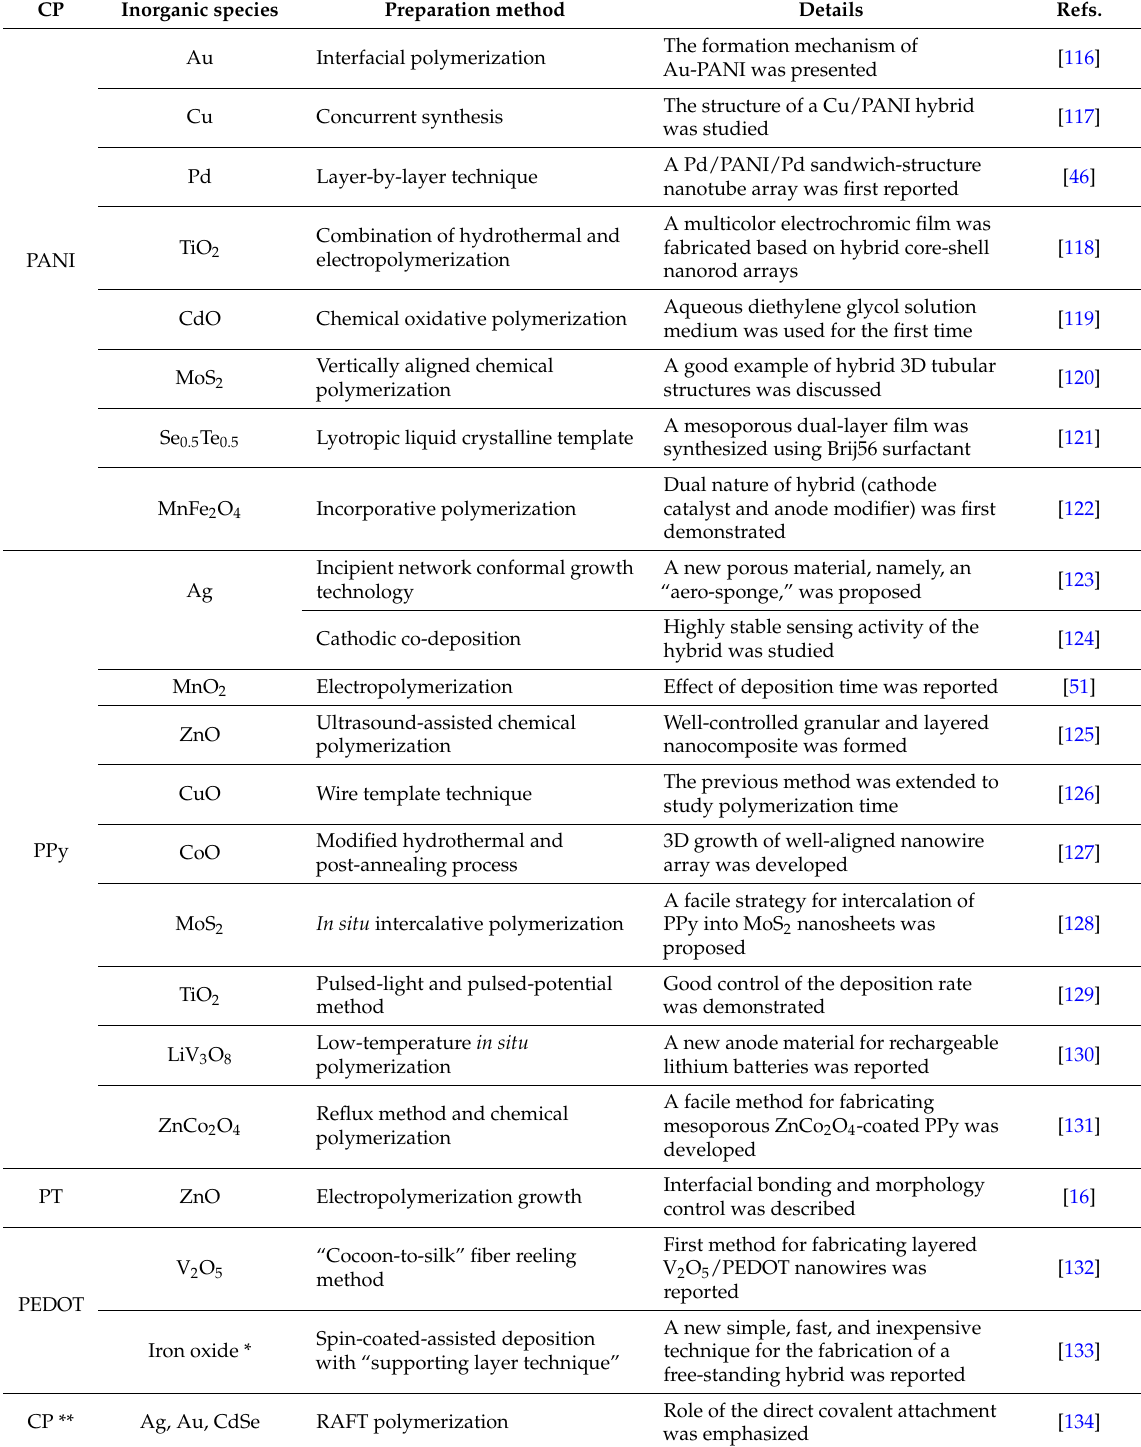
Table 6. Representative examples of the incorporation of inorganic species into